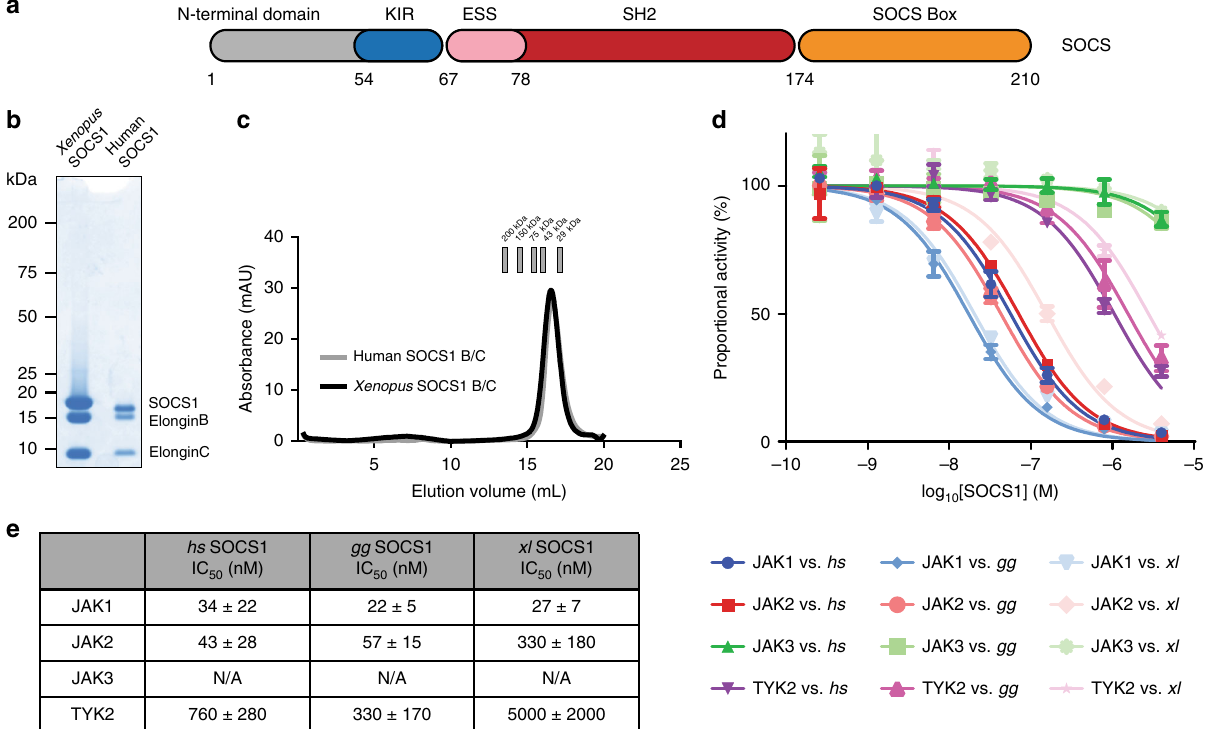
Fig. 1 SOCS1 is a direct inhibitor of JAK kinase activity. a Schematic representation of the SOCS1 domain architecture. SOCS1 consists of an unstructured N- terminal region, followed by the kinase inhibitory region (KIR), an extended SH2 subdomain (ESS), a SH2 domain and a SOCS box domain. b Puri fi ed recombinant SOCS1 in complex with Elongins B and C shown on Coomassie stained SDS-PAGE gel. c Gel fi ltration analysis of puri fi ed recombinant SOCS1 in complex with Elongins B and C. d Kinase inhibition assays indicate that SOCS1 from Homo sapiens ( hs ) , Gallus gallus ( gg ) and Xenopus laevis ( xl ) inhibits the kinase domains of JAK1, JAK2 and TYK2, but not JAK3. e IC 50 values of SOCS1 and SOCS3 constructs against JAKs as determined by kinase inhibition assays. The error bars shown in d represent the range of the data from two technical replicates whilst errors given in e are the standard error of the mean from 3 independent